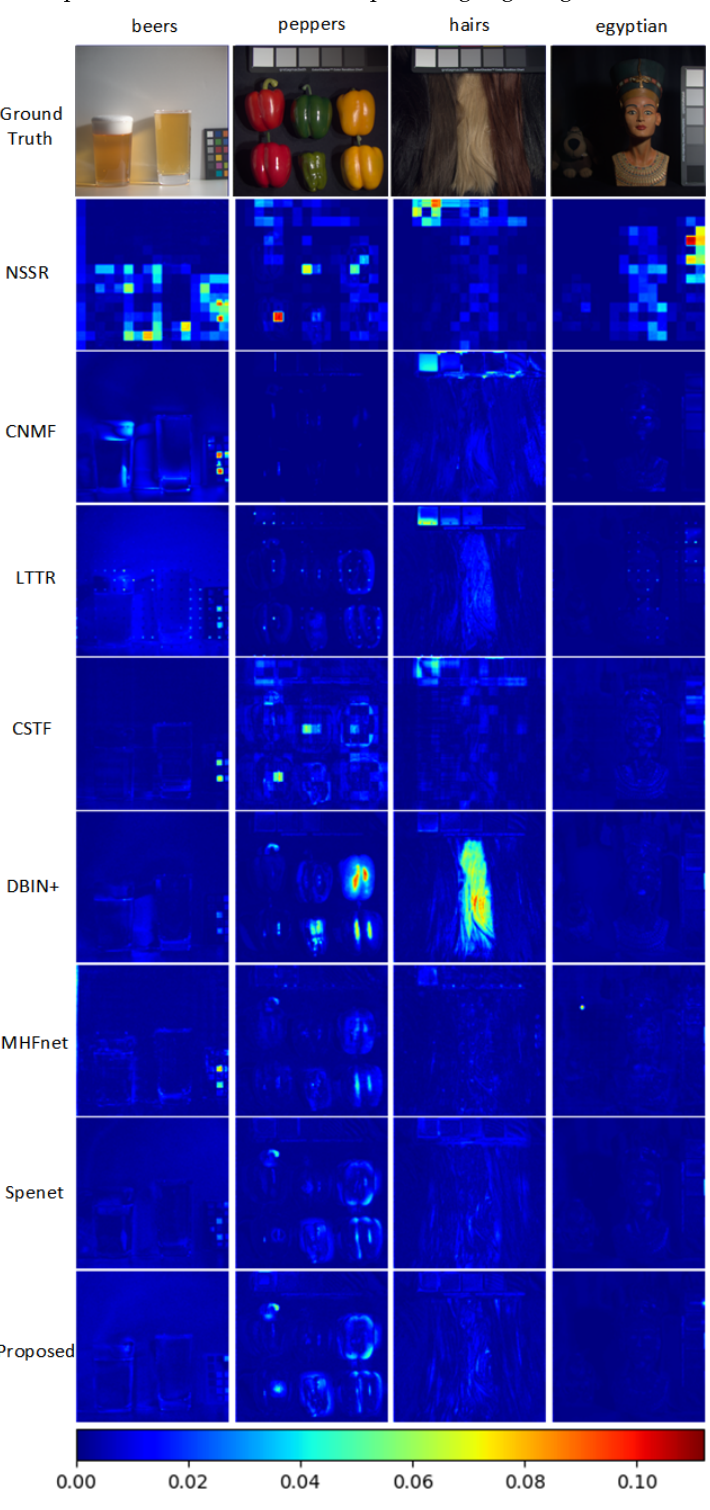
Figure 7. Comparisons of the error maps between the spectral bands of reconstructed